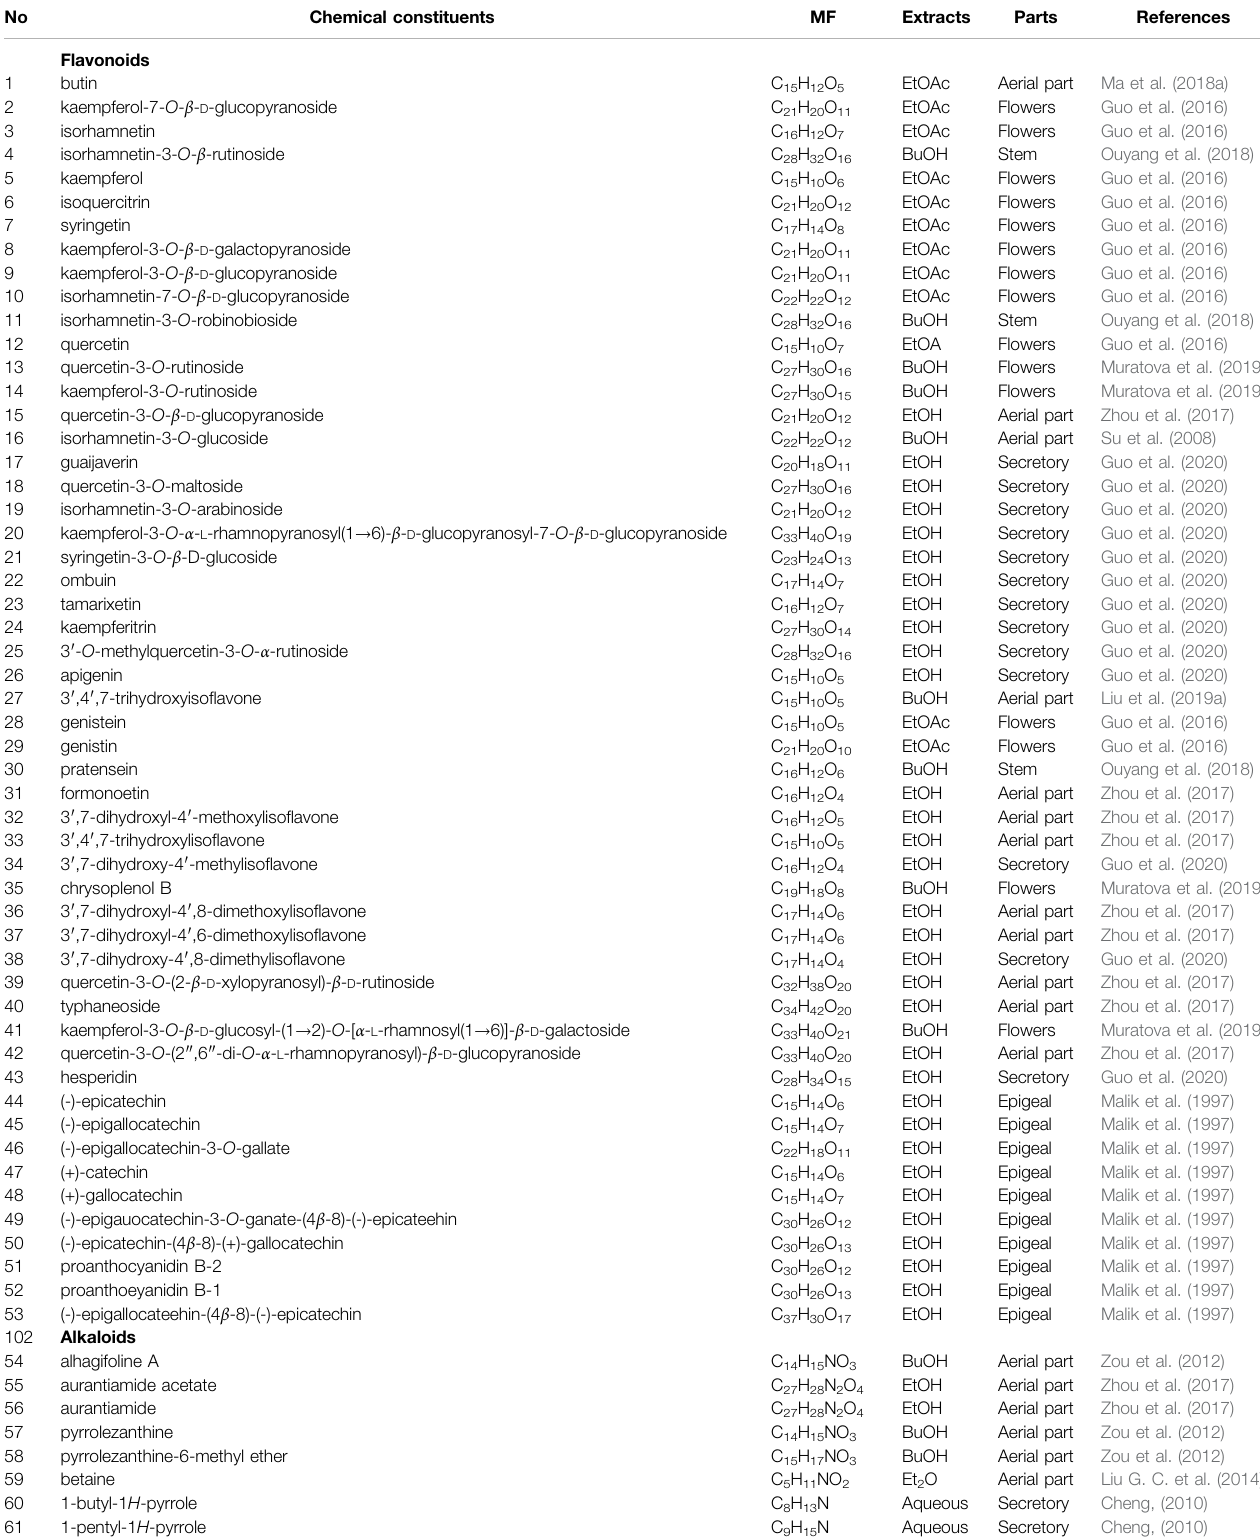
TABLE 2 | Chemical components isolated and structurally identi fi ed from A. sparsifolia (MF (cid:2) Molecular Formula).